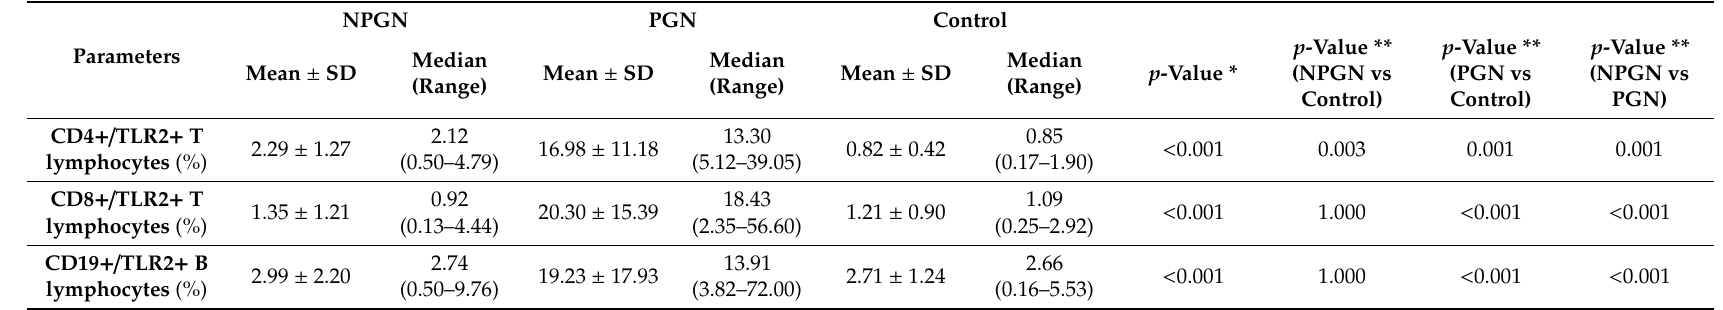
Table 3. Frequencies of TLR2 lymphocytes in patients with proliferative (PGN) and non-proliferative (NPGN) glomerulonephritis and